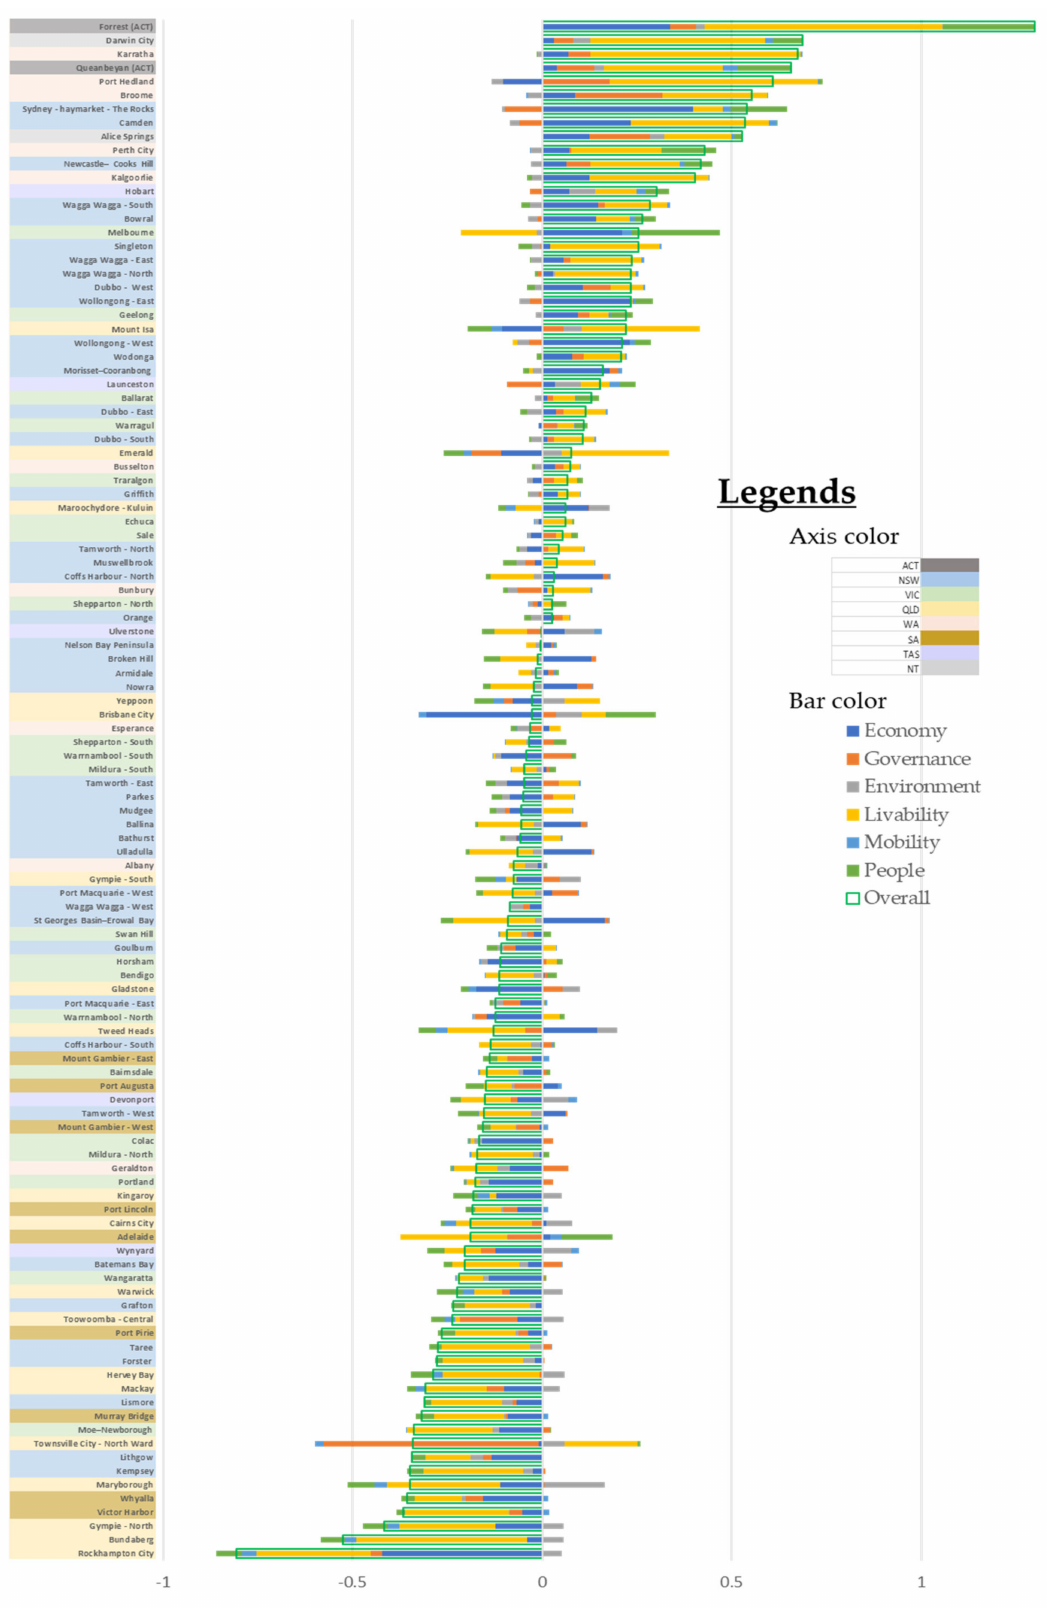
Figure 5. Preferred Cities arranged in a descending